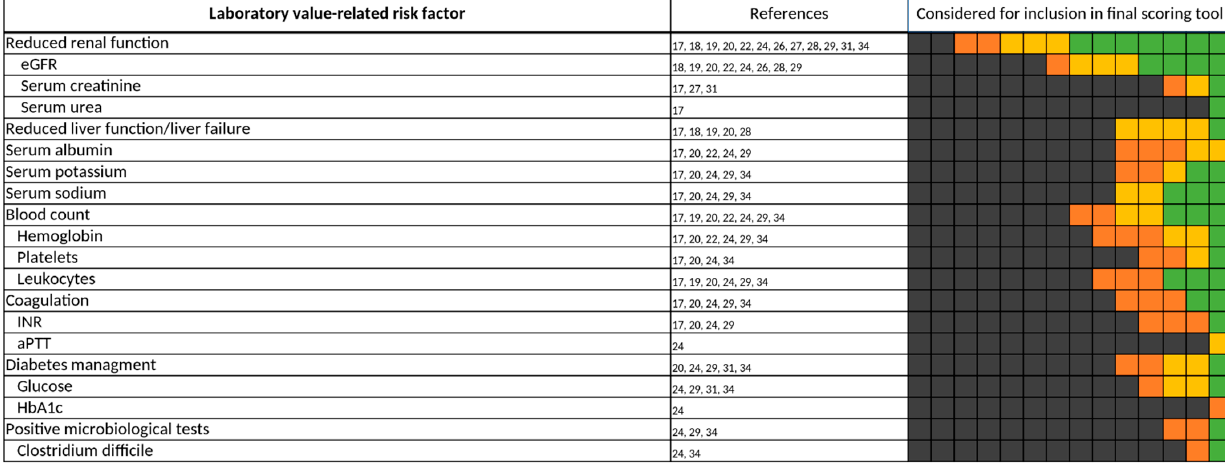
Figure 8. Laboratory value-related risk factors. Each of the 14 boxes represents one of the included studies. The color of the boxes portrays whether a risk factor was not investigated in a study (gray), was investigated (orange), was significant in a first statistical analysis or based on expert consensus and therefore tested for inclusion in a final scoring tool (yellow), or whether a risk factor was included in a final scoring tool (green). The “citations”-column lists each study that at least investigated the respective risk factor.